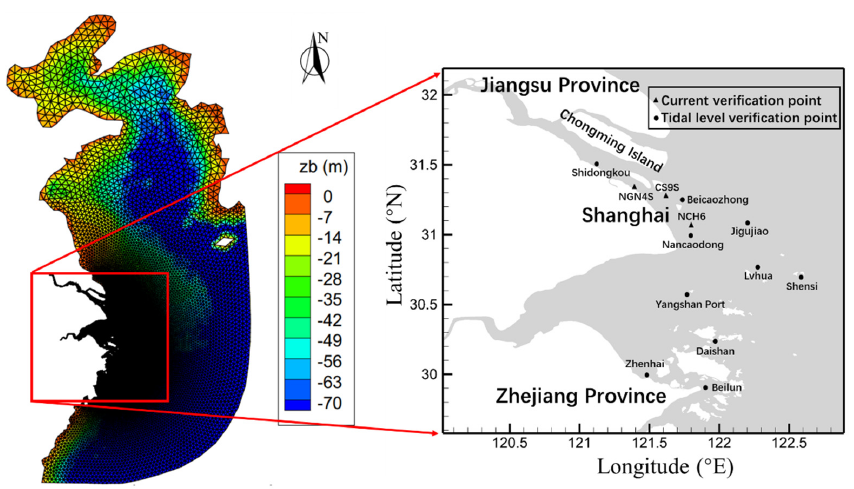
Figure 8. Initial bed topography of computational domain, unstructured mesh and stations for Yangtze estuary and Hangzhou bay case.